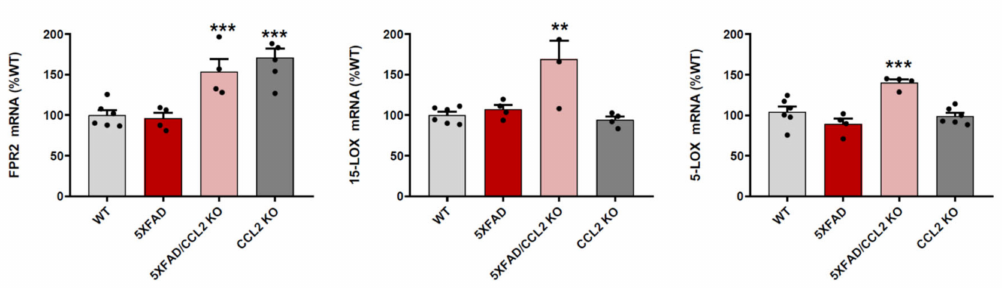
Figure 1. CCL2 deficiency increases the expression of pro-resolution mediators. FPR2, 15-LOX and 5-LOX mRNA concentrations were analyzed in brain cortex samples from WT, 5xFAD, CCL2-KO and 5xFAD/CCL2-KO mice. Data are means ± SE of n = 6 replicates per group. *** p < 0.001, ** p < 0.01 vs.